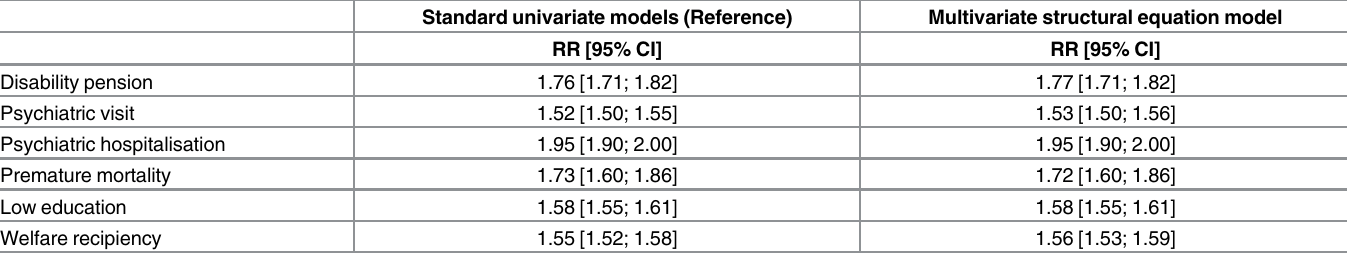
Table 3. Relative risks (RR) and corresponding 95% confidence intervals (CIs) for the associations between TBI before age 25 y and poor function- ing in adulthood, assessed in univariate and multivariate models.